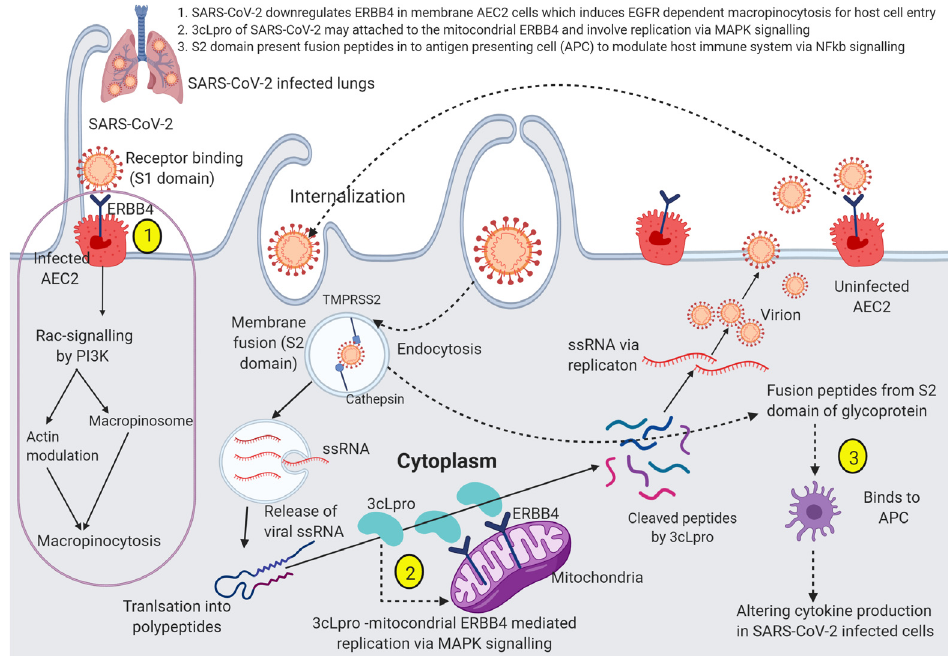
Figure 9. Hypothesized mechanism of action of downregulated ERBB4 in SARS-CoV-2 infected cells. There are three possible mechanisms (1) SARS-CoV-2 an enveloped single-strand RNA virus, virions are internalized probably by receptor tyrosine kinase (EGFR) family receptor ERBB4 dependent macropinocytosis like SARS-CoV-1 (the process of macropinocytosis indicated in magenta circle). The cellular entry of SARS-CoV-2 involves binding to ERBB4 expressing AEC2 in the plasma membrane, macropinocytosis, and cathepsin based cleavage of the spike glycoproteins. The host transmembrane serine protease 2 (TMPRSS2) for spike priming and cathepsin cleaves spike glycoprotein S1 domain, permits fusion with endosomal membranes and release virions genome into the host cytoplasm; (2) Single-strand RNA translated polypeptides cleaved by the 3cLpro of SARS-CoV-2 possibly attached with mitochondrial ERBB4 and involve viral replication through MAPK signaling pathway. Then, the cell to cell spread action, the replicated SARS-CoV-2 attached to the uninfected AEC2 receptor and then restart macropinocytosis; (3) The part of S2 domain presents peptides into antigen-presenting cells (APC) to modulate host immune system through NFkB-